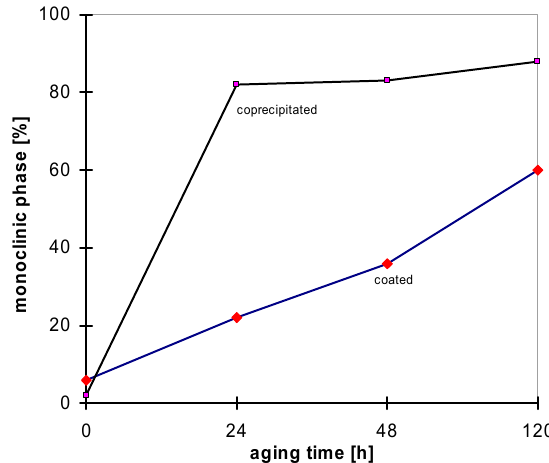
Figure 19. Monoclinic phase of Y-TZP after hydrothermal ageing.